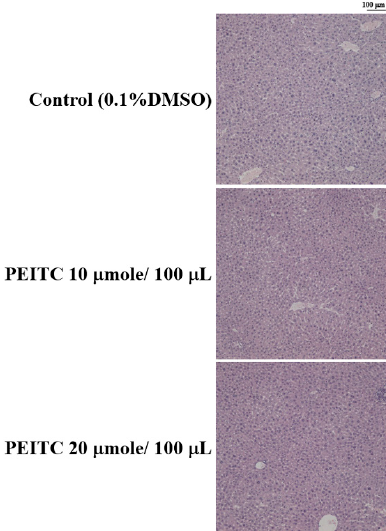
Figure 4. The effects of PEITC on liver histopathology in GBM 8401/ luc2 cells xenograft animal model. Liver tissue from every mouse of every group after treatment was collected and stained with hematoxylin and eosin (H&E). Liver specimens from PEITC-treated and control groups revealed similar structures of hepatocytes and lobular architectures.